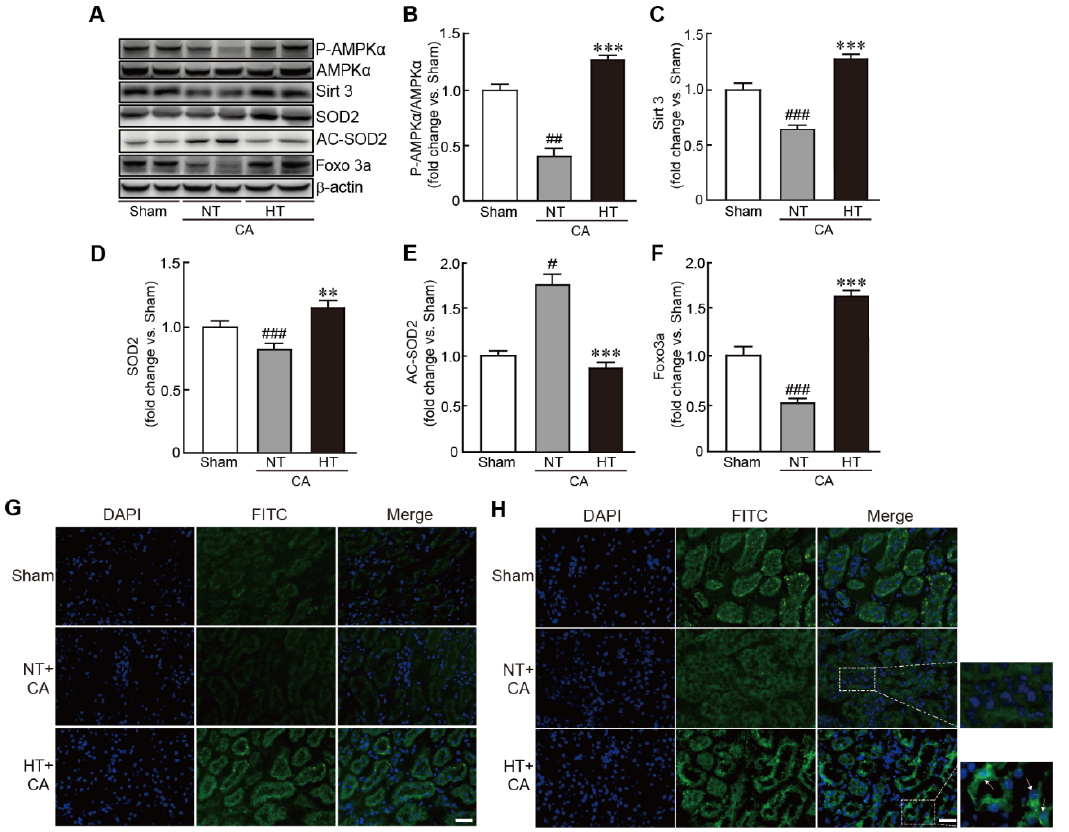
Figure 8. Olanzapine-induced TH activates the Sirt3-related signaling pathway in CA-induced renal tissues. ( A – F ) Western blot analysis for measuring the expression levels of proteins involved in the Sirt3 signaling pathway in rat tissues after CA and ROSC with or without olanzapine-induced TH ( n = 3 per group). Representative photographs of Sirt3 ( G ) and FOXO3a ( H ) protein staining results in rat tissues after CA and ROSC with or without olanzapine-induced TH. Arrows indicate the cells that contain Sirt3 in the nucleus. Significance is represented as ## p < 0.01 and ### p < 0.001 vs. the sham group; ** p < 0.01 and *** p < 0.001 vs. the CA + NT group. CA, cardiac arrest; TH, therapeutic hypothermia; NT, normothermia; HT, hypothermia. Scale bar, 100 µ